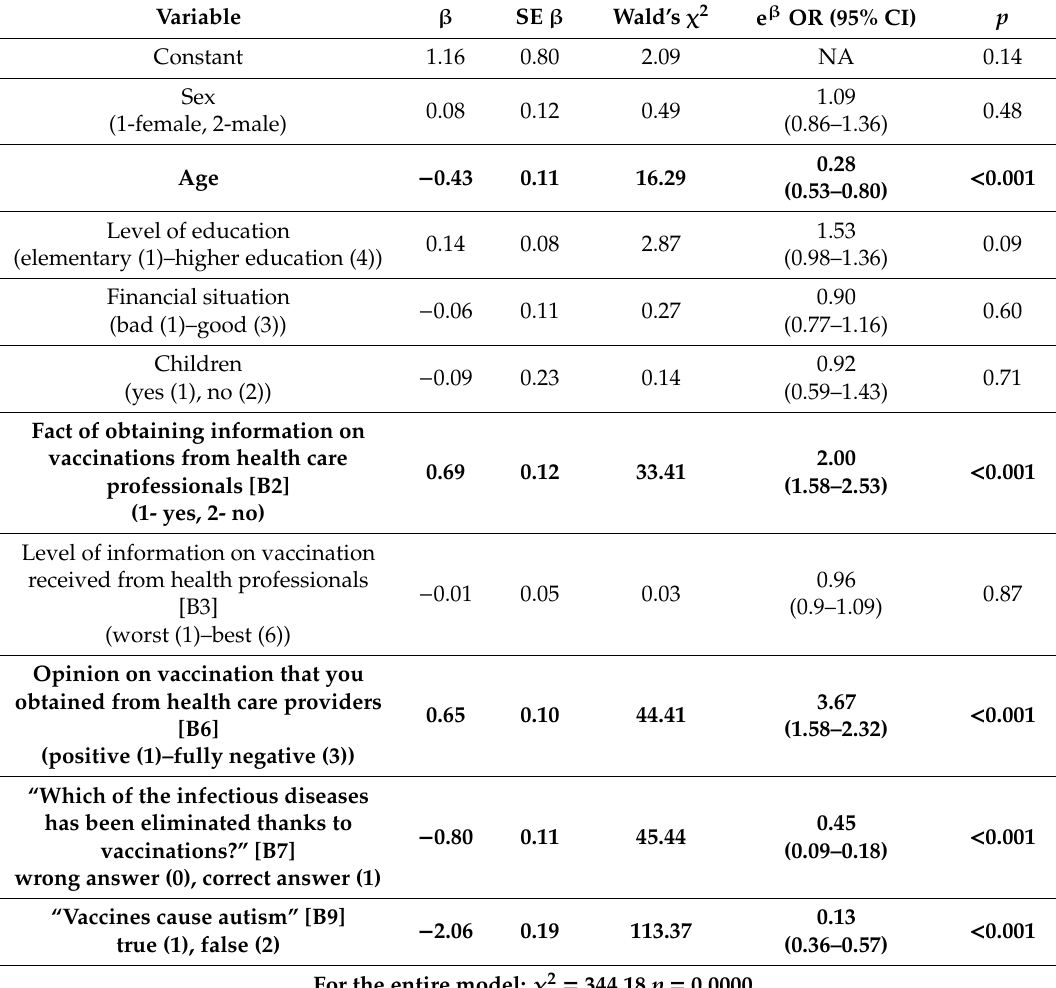
Table 3. Logistic regression model parameters and odds ratios-dependent variable: answer to the question B8: “Do you consider yourself an advocate / opponent of vaccination?” (advocate (1), opponent (2)). Bold values denote statistical significance at the p < 0.05